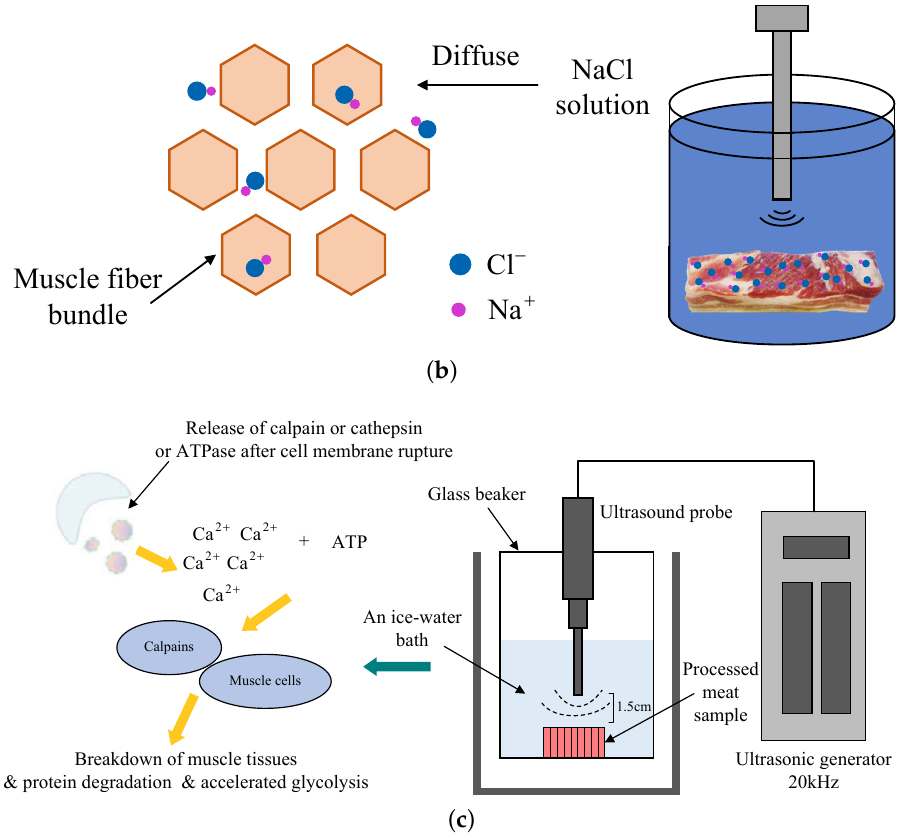
Figure 5. The possible sensory defects in Jinhua ham, application and principle of ultrasound in meat products processing. ( a ) The possible sensory defects in Jinhua ham [66]. ( b ) Schematic diagram of NaCl diffusion during the salting processing in the muscle promoted by ultrasound wave. ( c ) The processing of the release and activation of proteases promoted by ultrasound